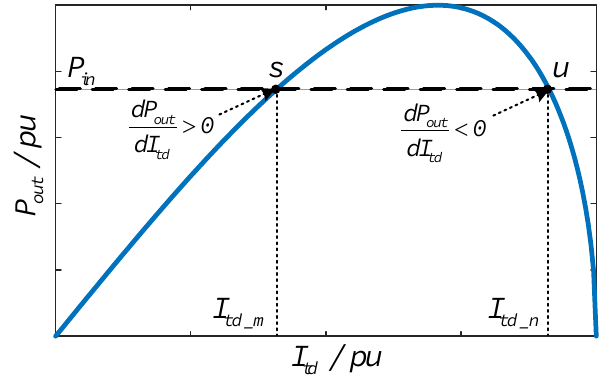
Figure 4. Output power characteristic curve ( I tq = 0 ).